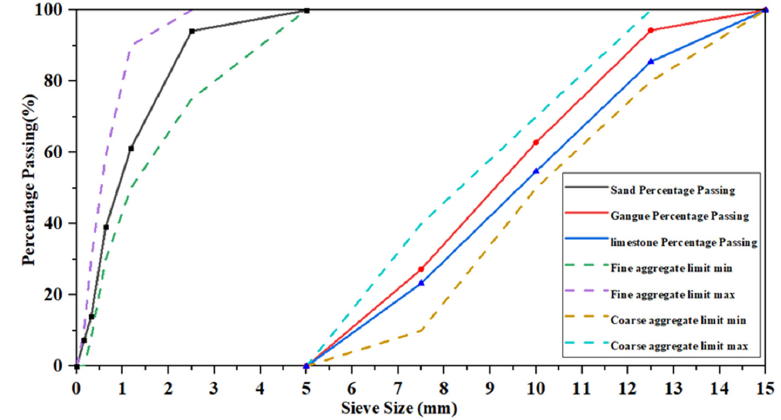
Figure1. Aggregate grading curve. Figure 1. Aggregate grading curve.